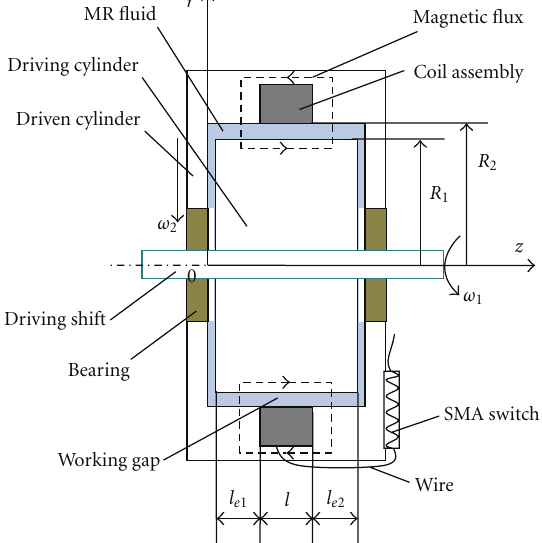
Figure 1: Schematic of a cylindrical MR variable transmission.